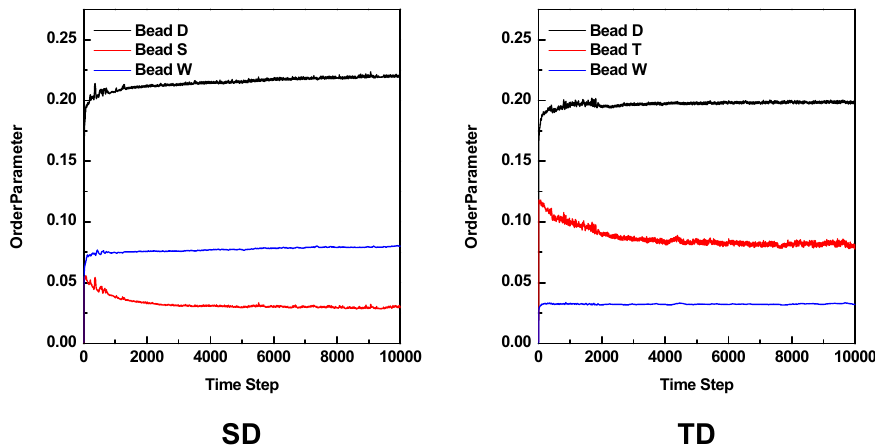
Figure 5. Order parameter as a function of the time step of the mesoscale models at 298 K after 10,000 steps.